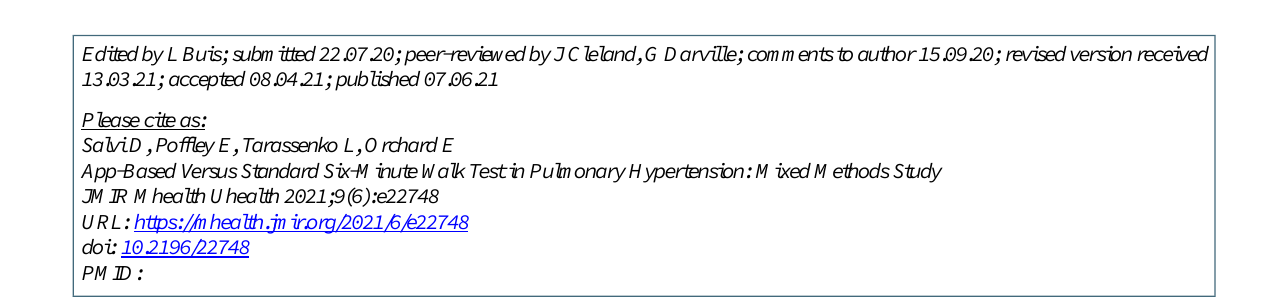
SpO : peripheral oxygen saturation 2